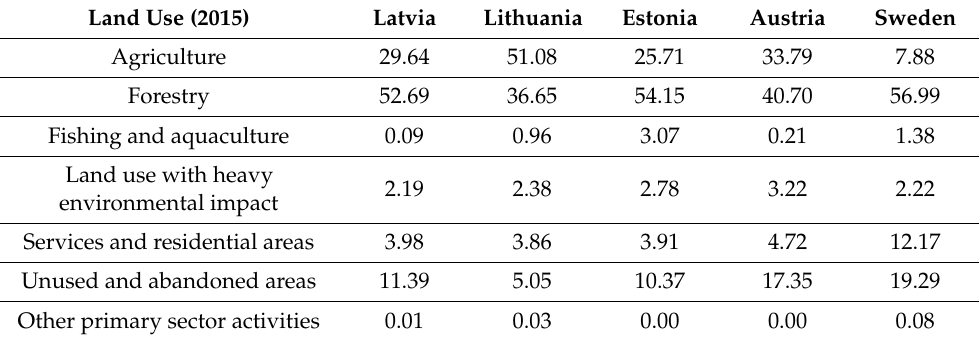
Table 2. Functional land use (land-use types) according to Eurostat data (2015) shares (%) in selected European countries [50].